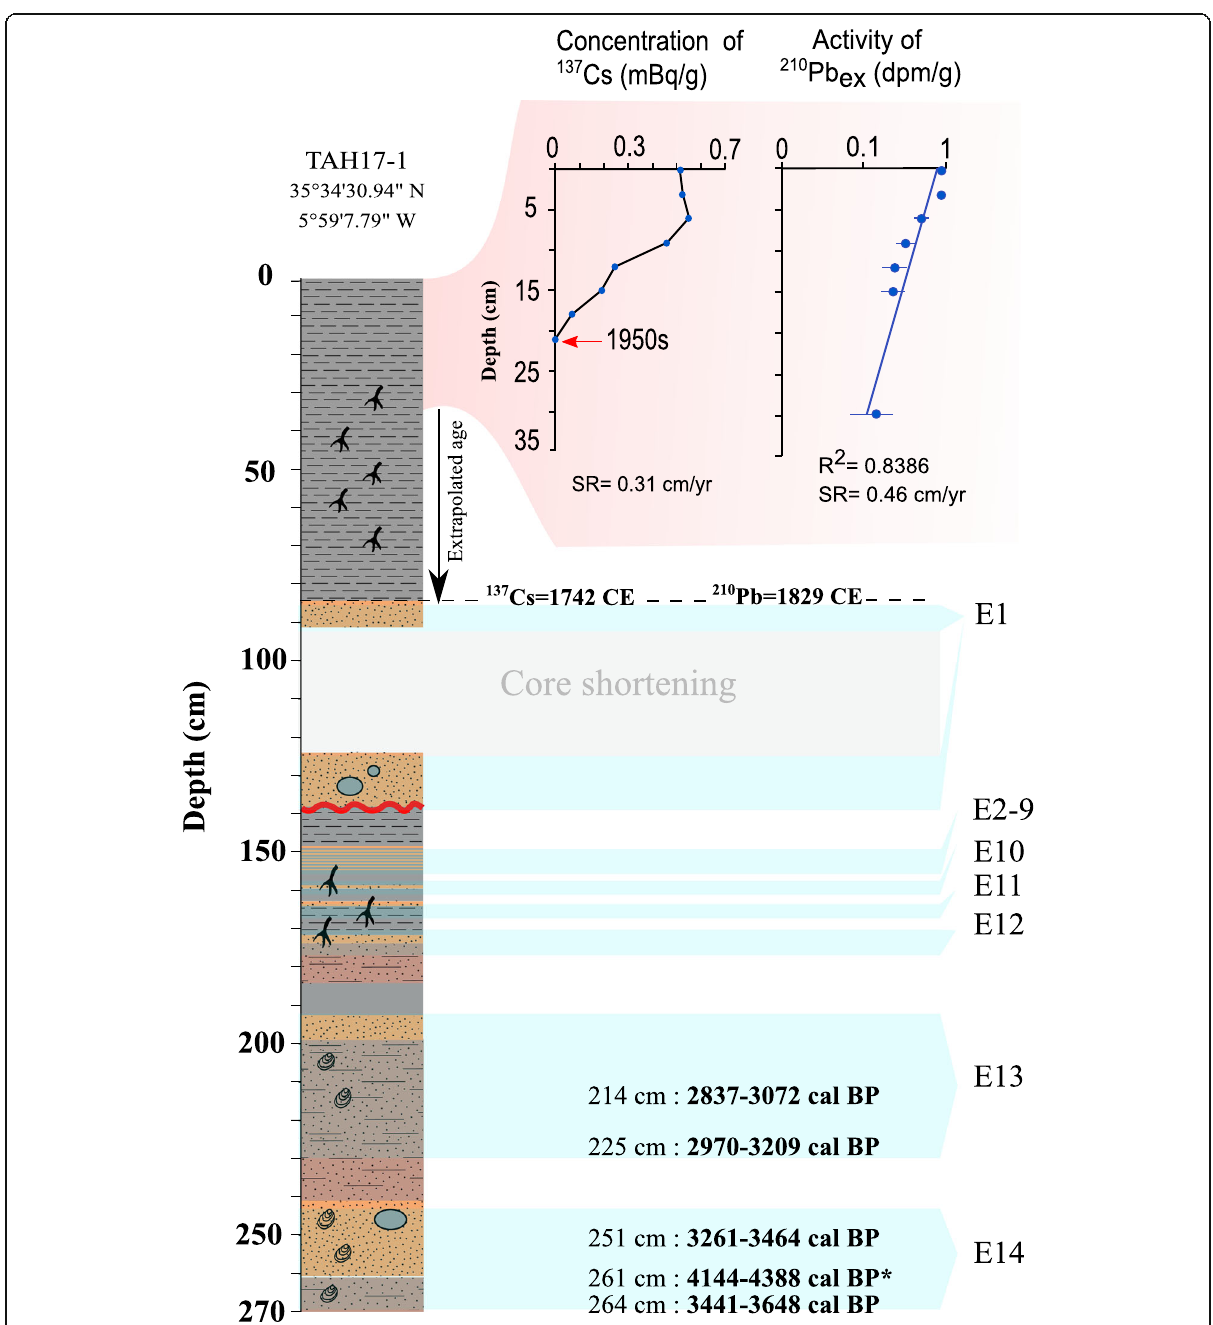
Fig. 4 Schematic log of the TAH17 – 1 core presenting chronological data from 137Cs, 210Pb and 14C. Sample with asterisk marks remobilized material (see text for